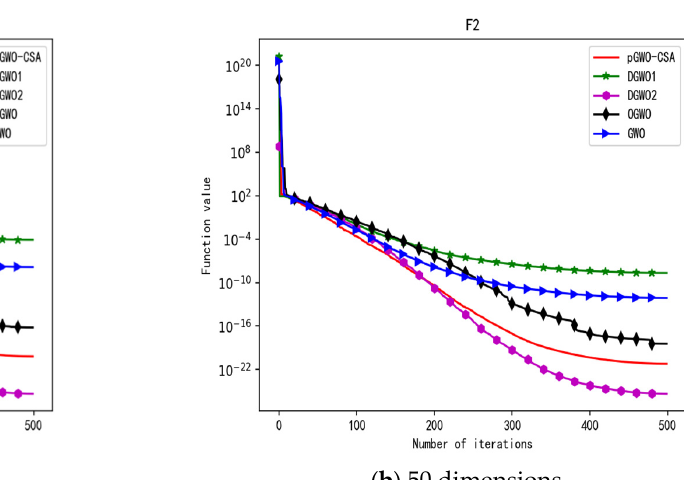
Figure 20. Convergence curve of test function F1.